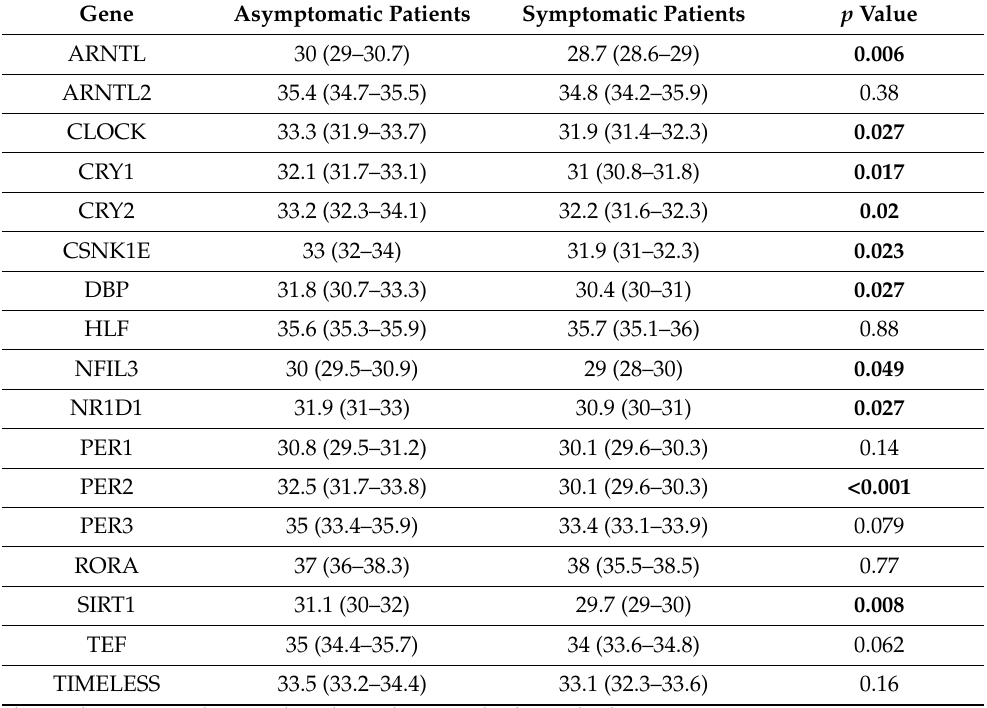
Table 4. Differences in circadian genes expression between patients with signs and symptoms of porphyrias and asymptomatic porphyria